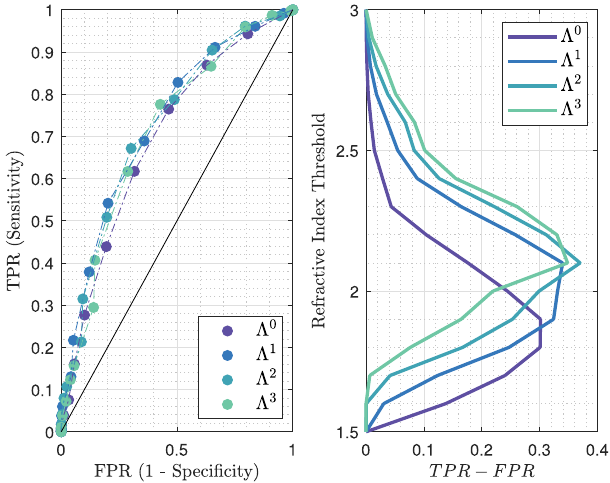
Figure 11. Left: receiver operating characteristic for the different classification methods, at 550-GHz applied to TS#2. The black line stands for TPR = FPR . Right: refractive index threshold as a function of the TPR − FPR measure for the different classifiers.